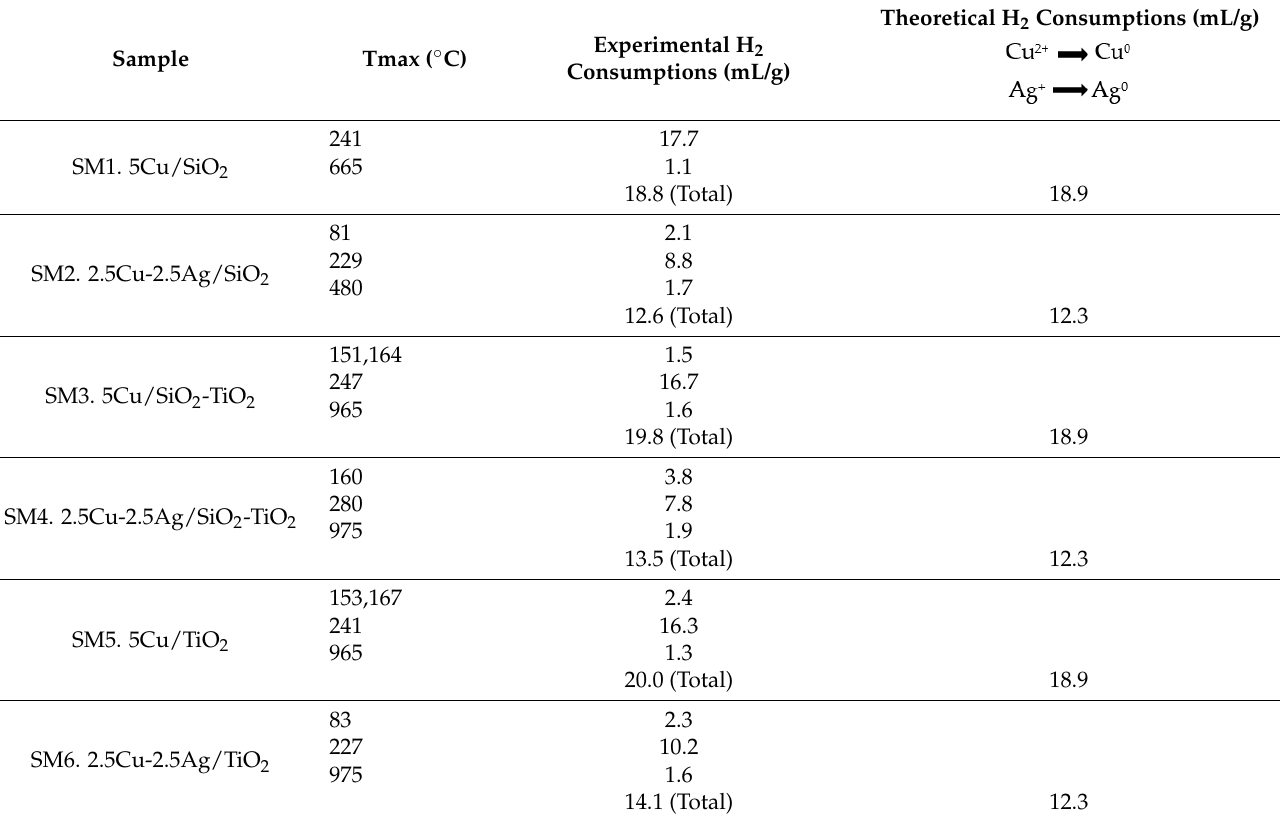
Figure 3. H 2 -TPR profiles of the calcined solids: ( a ) Cu-based, ( b ) Cu-Ag- and Ag-based materials. Table 2. Reduction temperatures and H 2 consumption values.